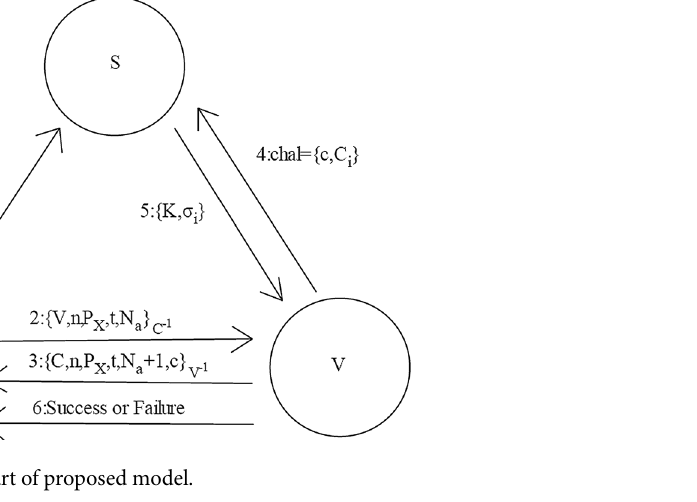
Figure 3. Flowchart of proposed